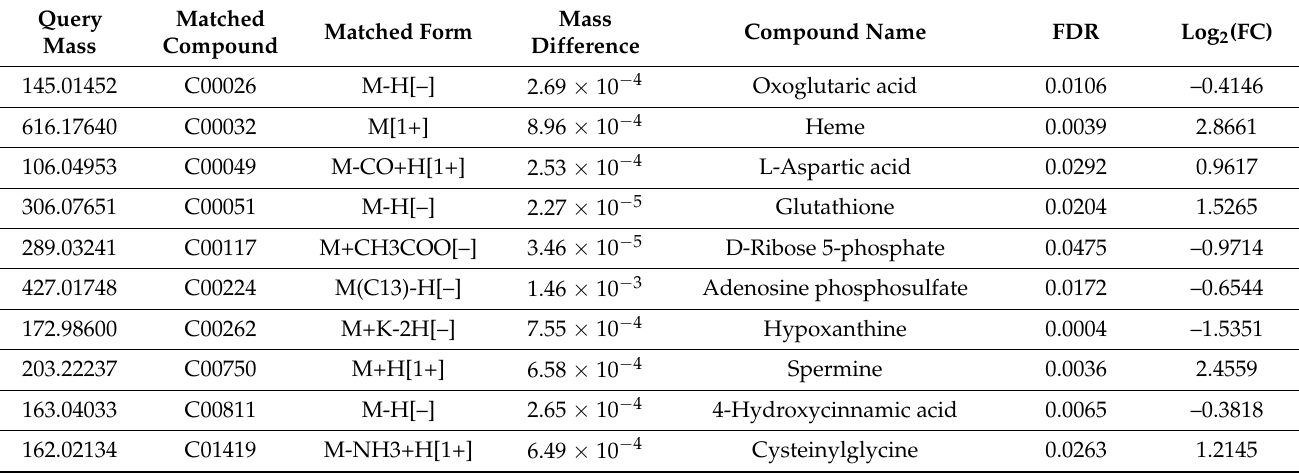
Table 4. List of metabolites identified in the leaves of young oil palm plants submitted to salinity stress via metabolomics analysis, after submitting the differentially expressed (DE) peaks to the pathway topology analysis module in MetaboAnalyst 5.0. FDR: False Discovery Rate; and FC: Fold